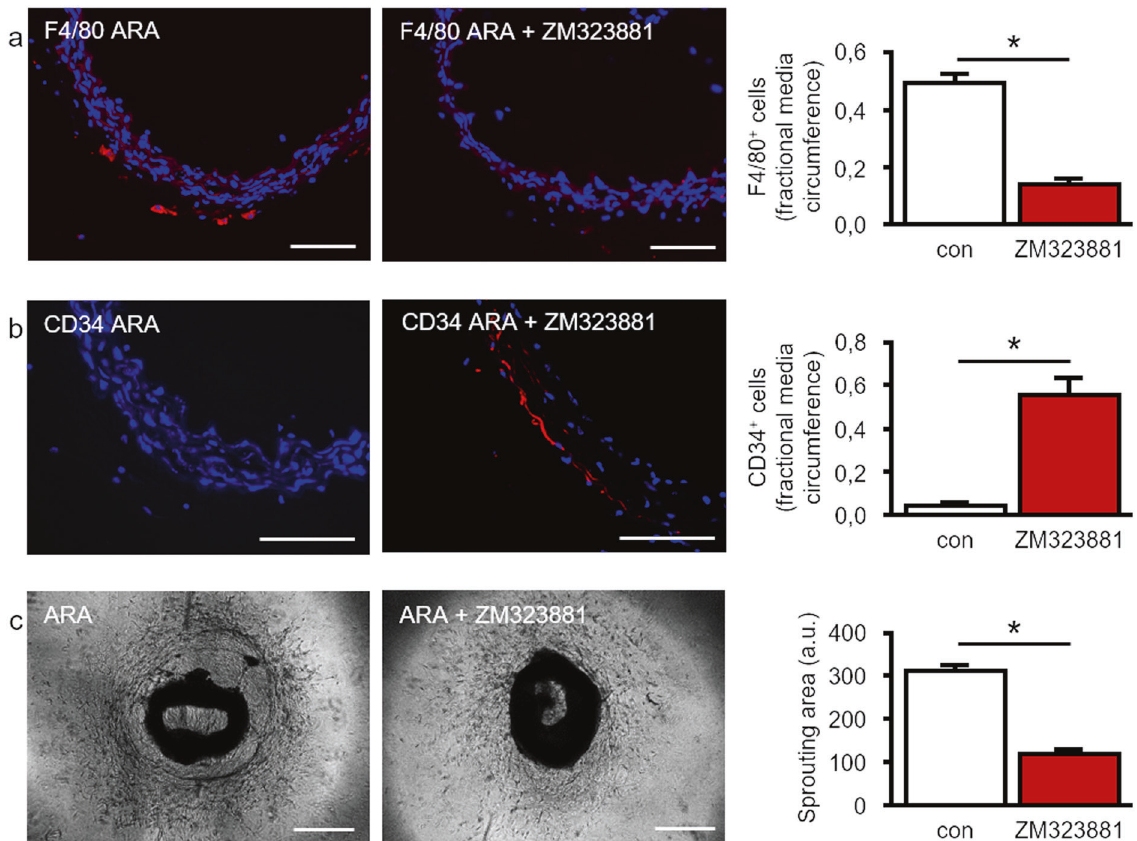
Fig. 6 Macrophage-derived VEGF activates the vasculogenic zone and promotes macrophage generation. a After ARA, a substantial number of F4/80 + macrophages was generated whereas hardly any macrophage was detected after ARA in the presence of the VEGFR2 antagonist ZM323881 (1µM). For quanti fi cation, the fraction of media circumference that is covered by F4/80 + cells was analyzed ( n ≥ 5). b Furthermore, the application of ZM323881 (1µM) resulted in the preservation of CD34 + cells within the adventitial vasculogenic zone. For quanti fi cation, the fraction of